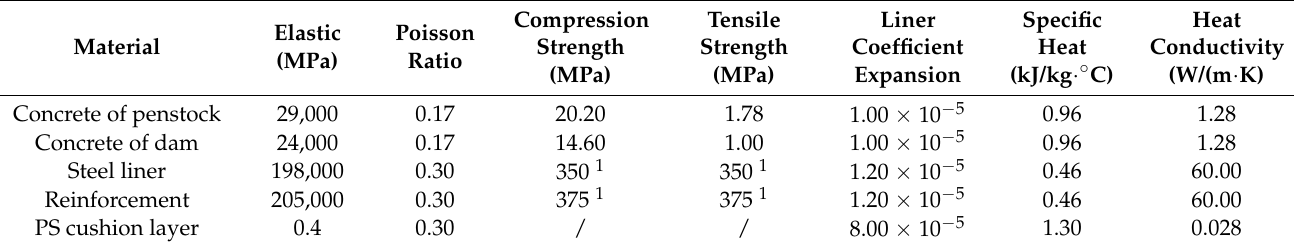
Table 1. Mechanical and thermal properties of the test model.